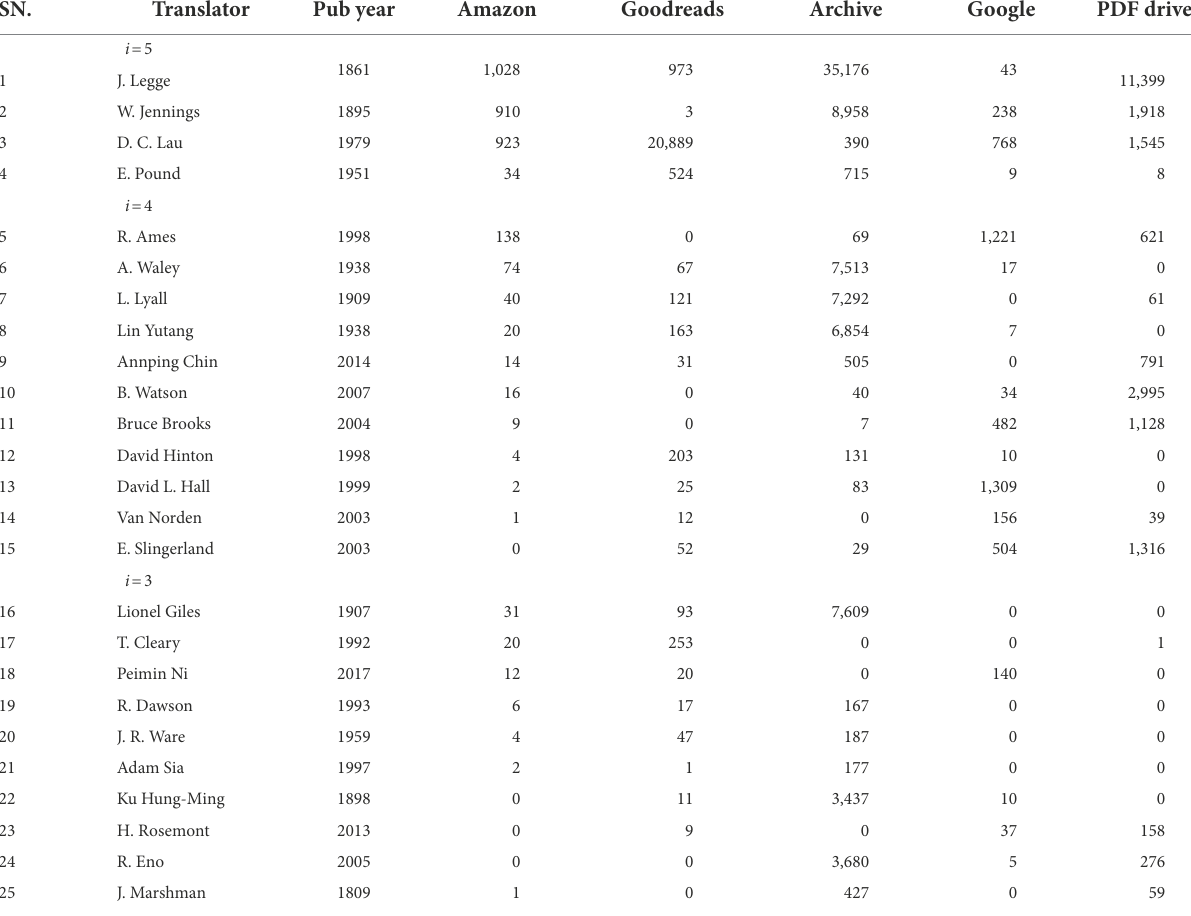
TABLE 2 Data for English translations of The Analects appearing in three or more of the five investigated websites.